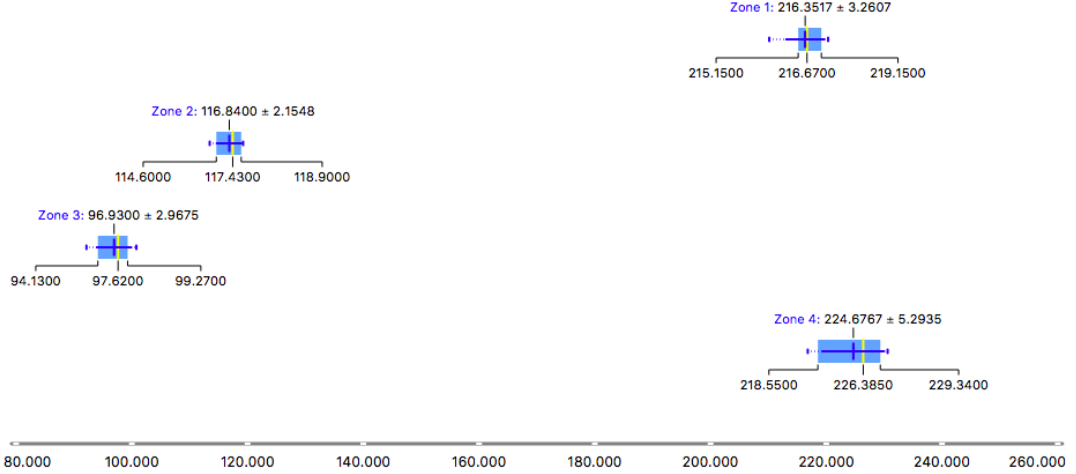
Figure 12. Box Plot zones measures on Plaza Balmis